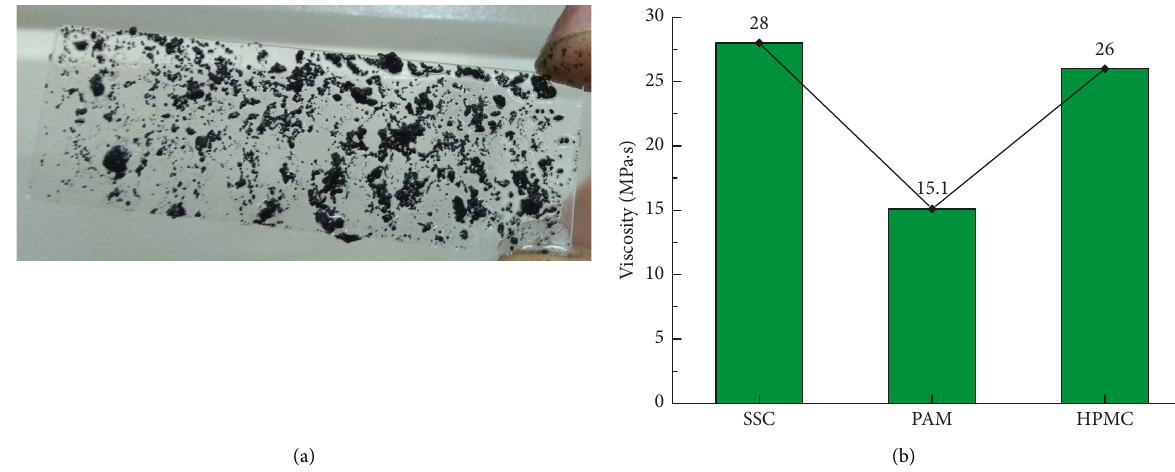
Figure 7: (a) Adhesive capacity of the SSC for the coal dust particles. (b) Comparison of the viscosities of the PAM, HPMC, and SSC.